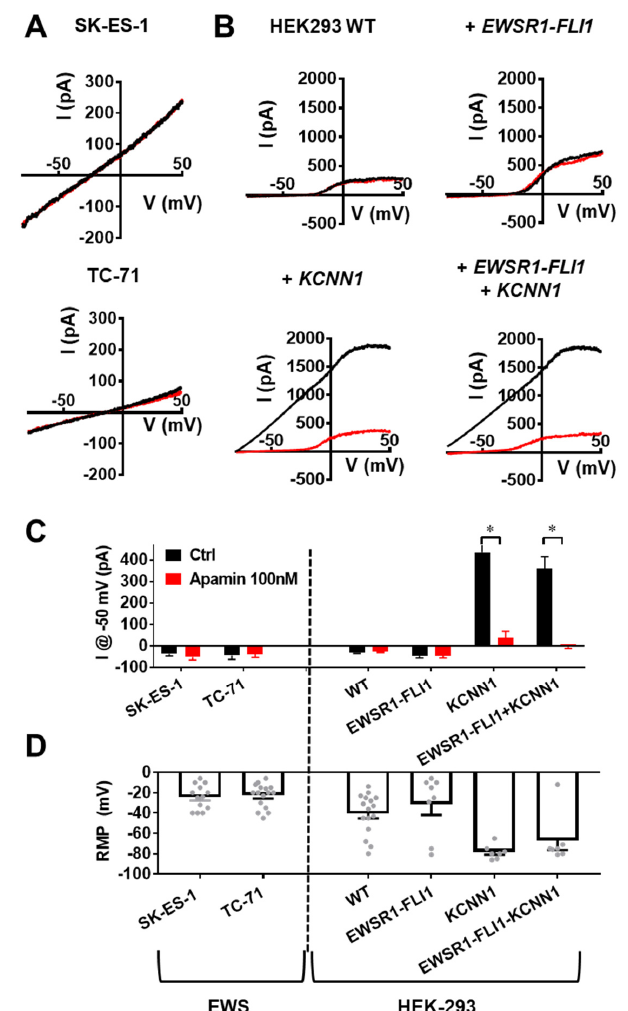
Figure 6. K Ca 2.1 channels are non-conducting in EwS cells. ( A ) Representative whole-cell patch- clamp recordings of SK-ES-1 (top) and TC-71 (bottom) cells under control conditions (black) or in the presence of 100 nM apamin (red). Voltage ramp was applied between − 80 and +50 mV in 5 s. ( B ) Representative whole-cell patch-clamp recordings of HEK293 cells transfected with either control (HEK − 293 WT, top left), EWSR1-FLI1 (top right), KCNN1 (bottom left) or both EWSR1-FL1 and KCNN1 (bottom right), under control conditions (black) or with 100 nM apamin superfusion (red). ( C ) Quantification of whole-cell currents at − 50 mV under control conditions (black) or in the pres- ence of 100 nM apamin (red). ( D ) Resting membrane potential (RMP) of cells measured at the be- ginning of each experiment. Dashed line separates EwS cell lines (left) from transfected HEK293 cells (right) in ( C , D ). Data are represented as mean ± SEM. * p < 0.05